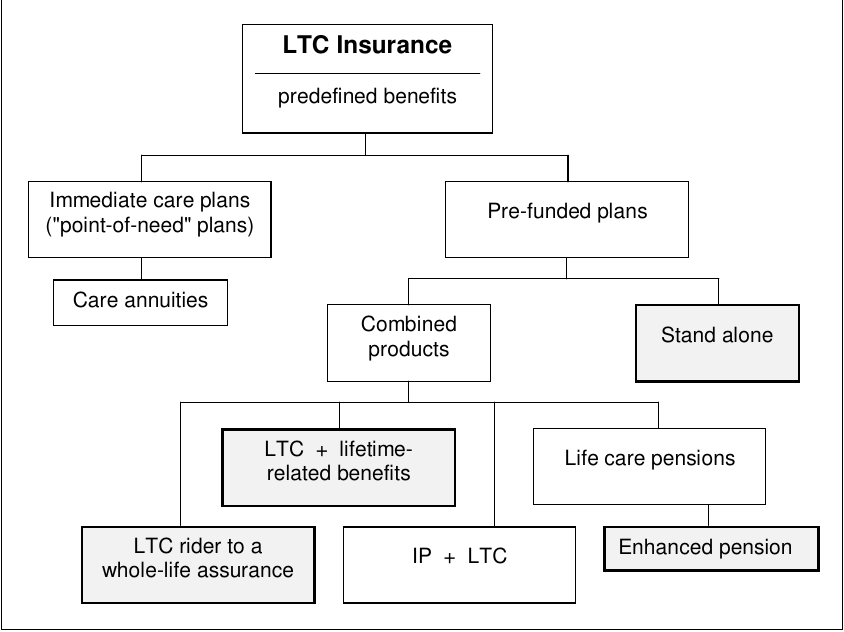
Figure 1. A classification of LTCI products providing predefined benefits (source: